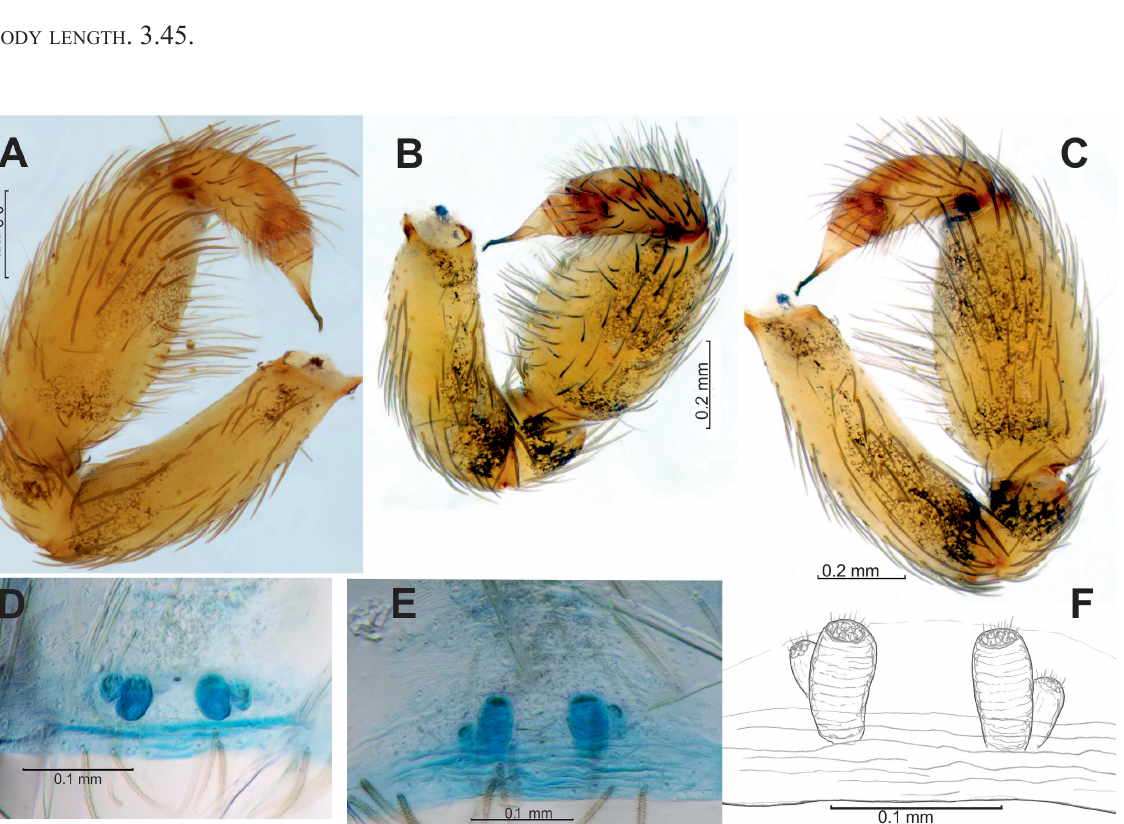
Fig. 9. Copulatory organs of Zaitunia annulipes (Kulczyński, 1908), ♂ from Paramali ( A–C ) and ♀ from Germasogenea ( D–F ). — A–C . Palp, prolateral, ventro-retrolateral and retrolateral. D . endogyne, anterior. E–F . Same, dorsal. Scale bars: a–C = 0.2 mm; D–F = 0.1